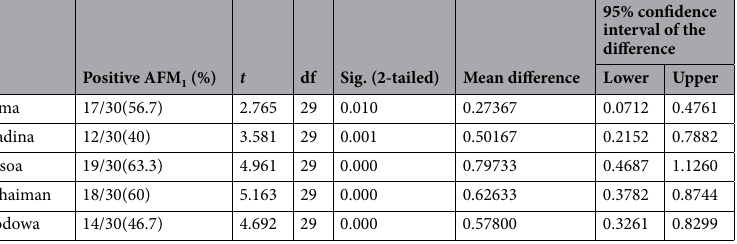
Table 3. Statistics of the one-sample t -test of brukina samples from different parts of the Greater Accra region, Ghana.